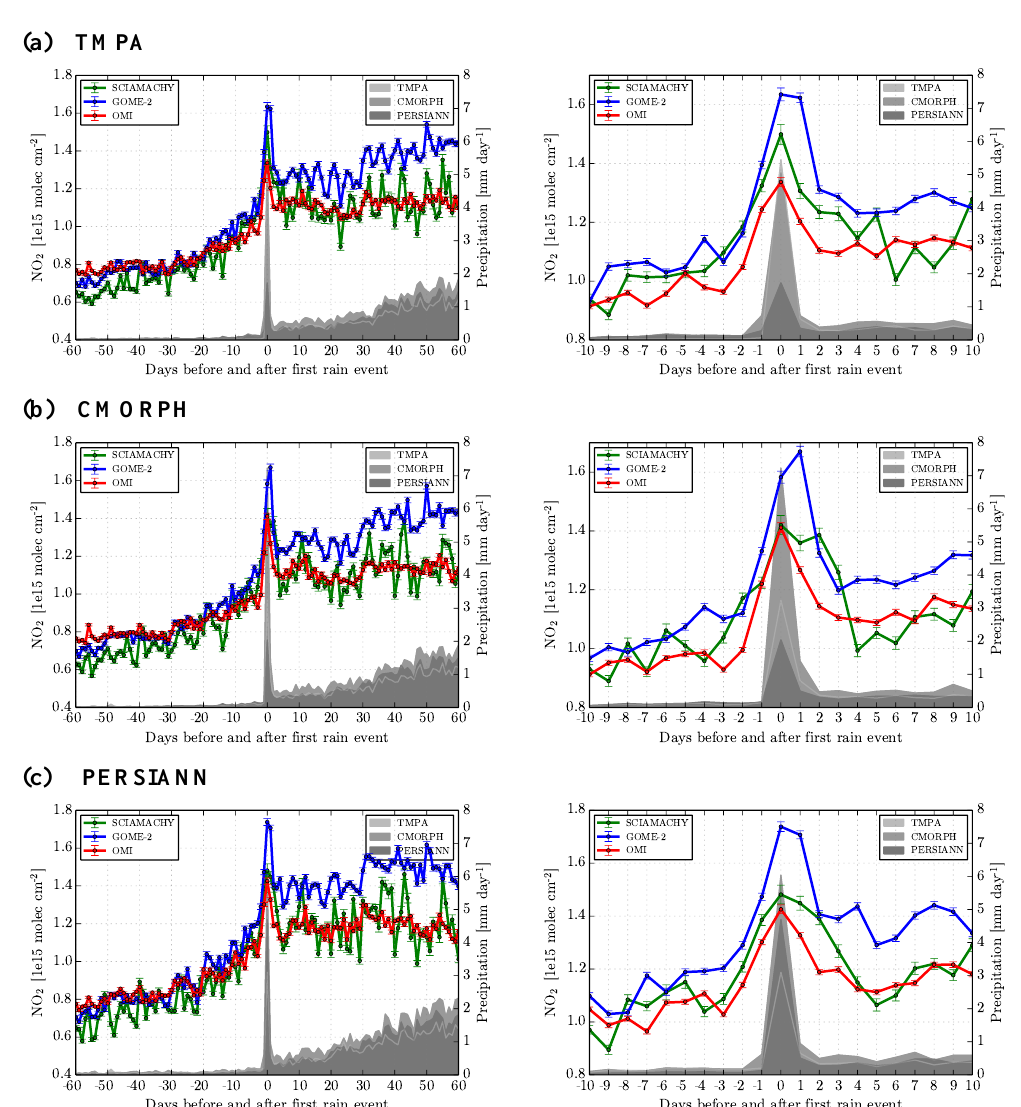
Figure A1. In this figure, NO 2 VCDs are shown (akin to Fig. 5e) from OMI (a) , GOME-2 (b) , SCIAMACHY (c) around the first day of rainfall for different precipitation products as trigger for the precipitation threshold of 2mm for the Sahel region. The left panels represent the full time series of 60 days before and after Day0, the right panels show a zoom-in for the 10 days before and after.